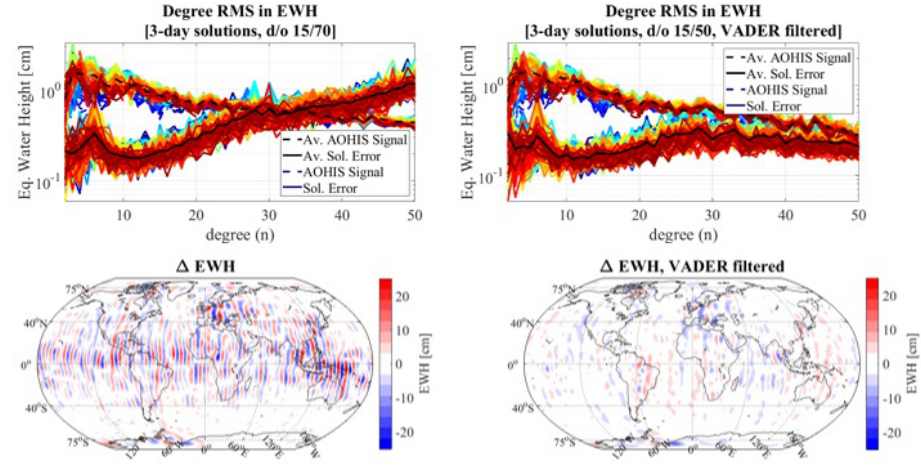
Fig. 1. Top: Degree RMS of the simulated EWH derived from the NGGM Bender pair without (left) and with (right) the VADER filter applied. All AOHIS signal as well as every error of the computed solutions is displayed in colours ranging from blue to red, with the average signal and error visualized in black. Bottom: Reconstructed AOHIS solution (first 3-day solution, d/o 50) minus the respective reference AOHIS signal without (left) and with (right) the VADER filter applied. The setting of the VADER filter is α =1000.